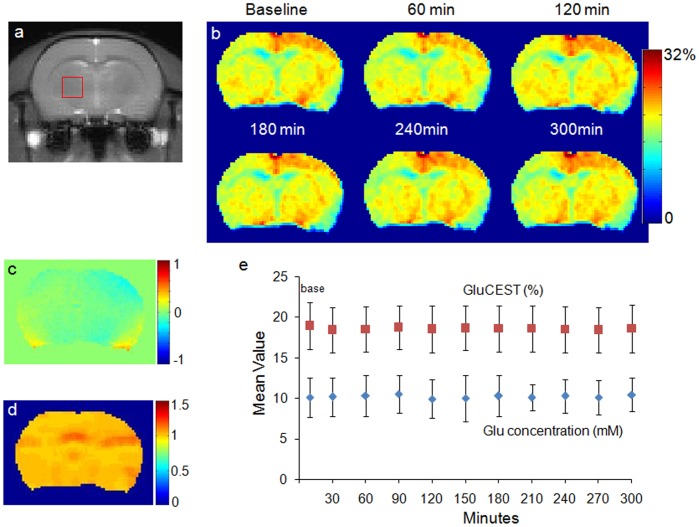
Chemical-exchange-saturation-transfer imaging of glutamate (GluCEST).(a) Anatomical brain image from one of the group 1 normal rat. (b) GluCEST maps of this rat brain pre and post Modafinil injection over time period of 5 hours. (c, d) B0 and B1 maps from corresponding brain slice as shown in (a). (e) graphs show no appreciable change in either mean GluCEST contrast or mean Glx concentration from 1HMRS over time period of 5 hours (n = 5) for the region of interest as shown in (a).